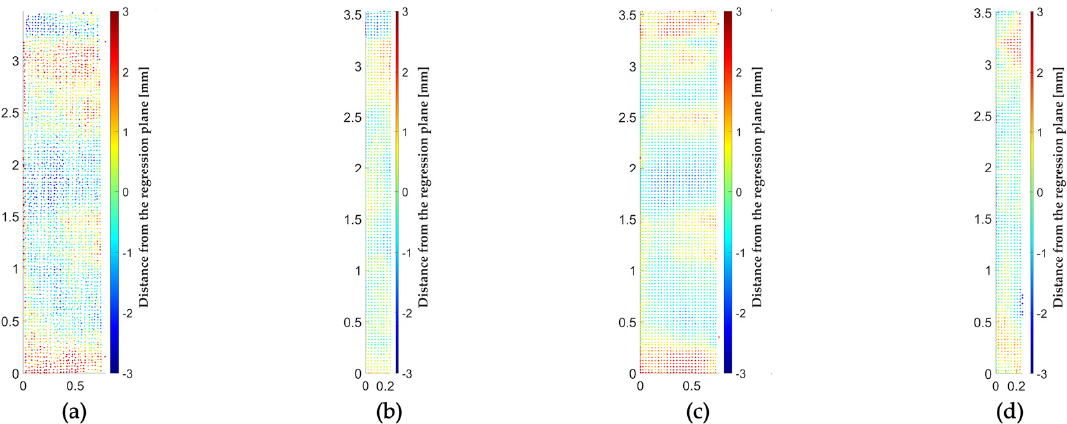
Figure 14. Comparison of the regression model and the segmented point cloud—column no. 2.: ( a ) plane oriented in the direction of + x -axis, ( b ) plane oriented in the direction of + y -axis, ( c ) plane oriented in the direction of − x -axis, ( d ) plane oriented in the direction of − y -axis. The proposed workflow for the inspection of cylindrical columns is demonstrated in the foyer of the DPOH theater in Bratislava (Figure 15). The LOD of the provided BIM model (in the form of an IFC file) can be characterized as LOD 300. The foyer was scanned using the Trimble TX5 instrument. The scanning parameters were set as follows: field of view 360 ◦ Hz × 305 ◦ V, resolution 1/10, which means 15.3 mm × 15.3 mm at 10 m, 3 × repetition of the measured distances. The chosen part of the foyer was scanned from three scanner positions. The point cloud registration was performed similarly to the previous case using surface-based registration and target-based registration. The resulting registration error was 9